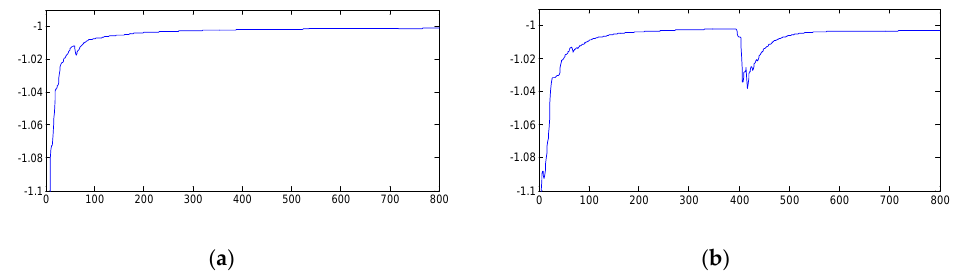
Figure 9. Time-varying kurtosis curves before and after noise suppression. ( a ) Curve of noisy PD signal. ( b ) Curve of de-noising PD signal.